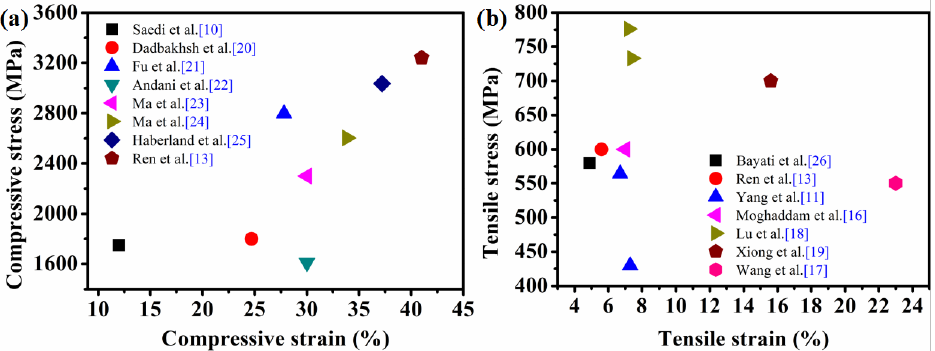
Figure 8. Compression and tensile properties of Ni-Ti alloy formed by SLM